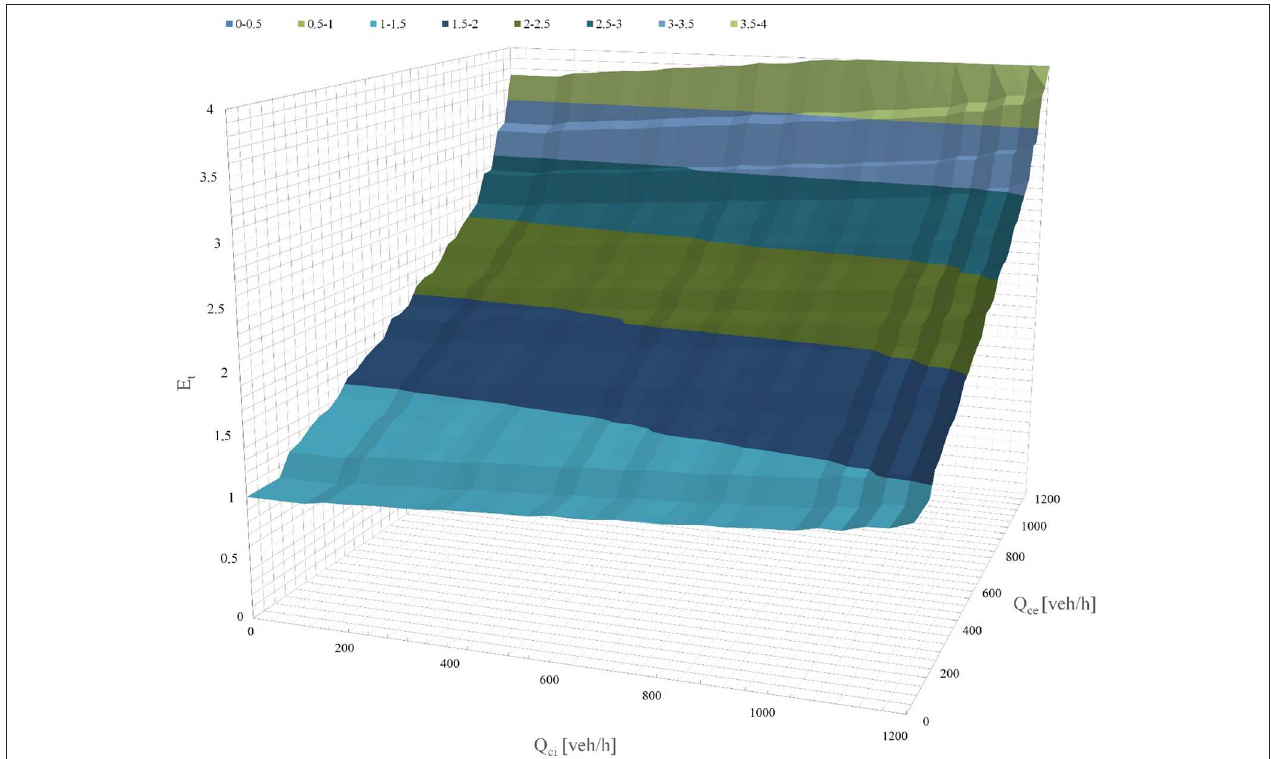
FIGURE 10 | PCE estimations for mean percentage of heavy vehicles between 10 and 20% for left entry lane at roundabout 1. E t , equivalece factor; Q ce , circulating flow on the outside lane [veh/h]; Q ci , circulating flow on the inside lane [veh/h].